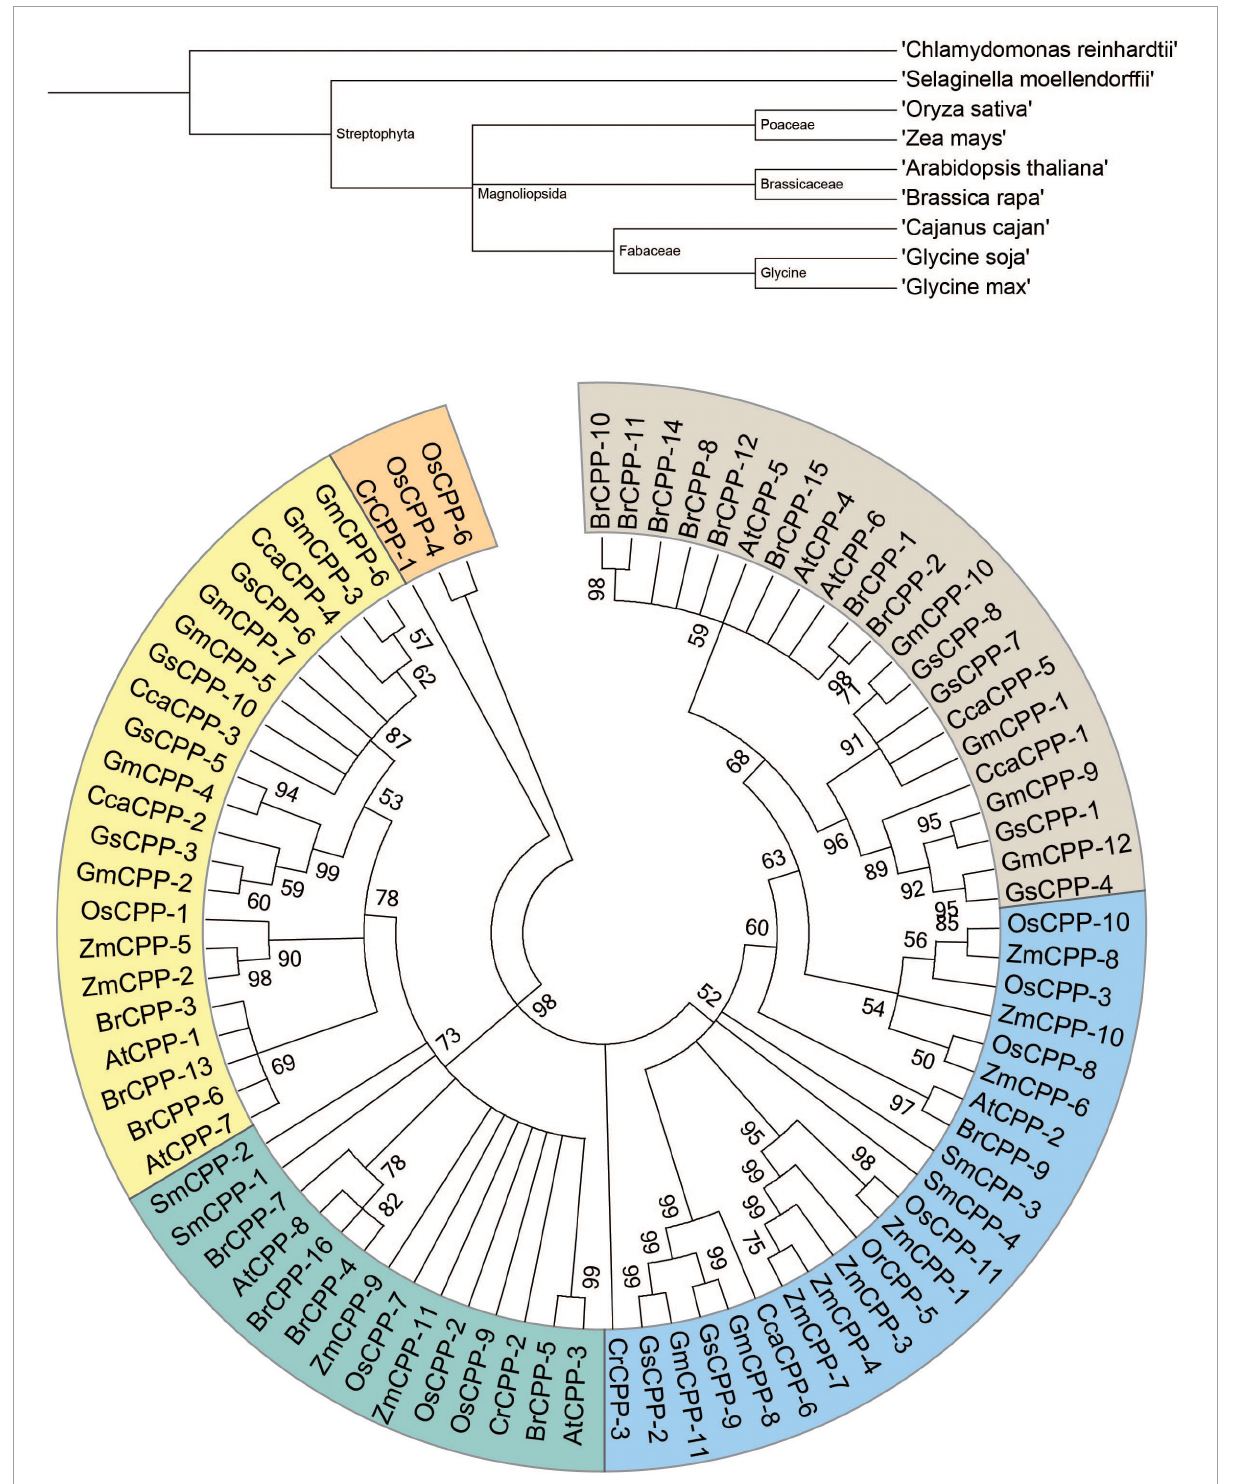
FIGURE1 Phylogenetic tree of GmCPPs from nine different species. Phylostartum analyses of CPP gene family (Upper portion) . Phylogenetic and evolutionary relationship of CPP gene family in soybean and other plant species (Lower portion) .